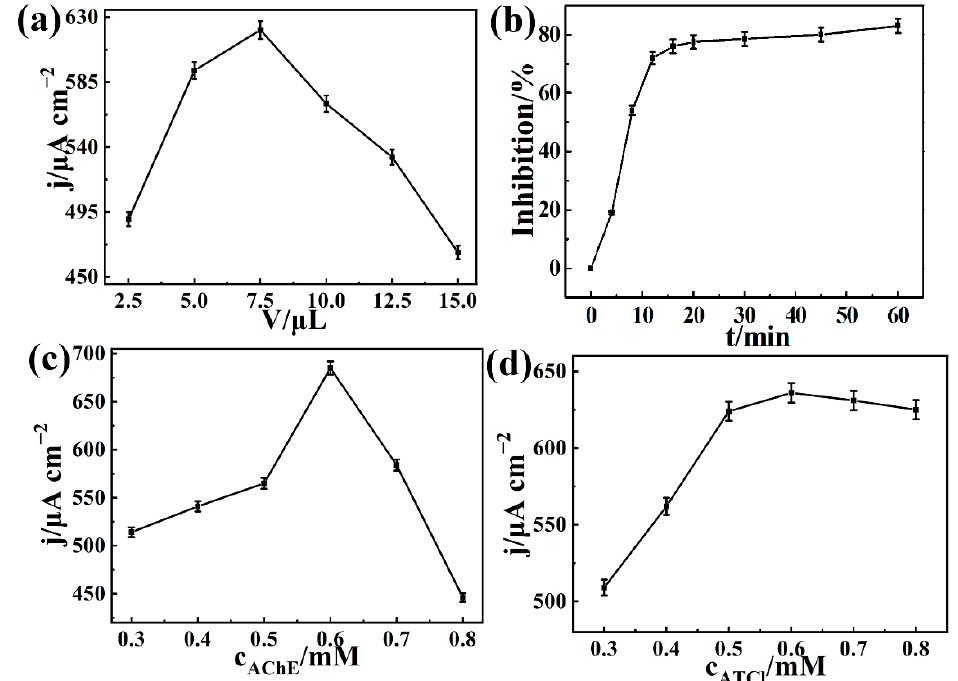
Figure 4. ( a ) Effect of COF DHNDA-BTH dosage on AChE/COF DHNDA-BTH /GCE on peak current density of 5.0 mM [Fe(CN) 6 ] 3 − /4 − . ( b ) Plot of inhibition rate versus incubation time. ( c ) Plot of peak current density versus AChE concentration. ( d ) Relationship between concentration of ATCl and peak current density in 0.1 M KCl with 5.0 mM [Fe(CN) 6 ] 3 − /4 − .